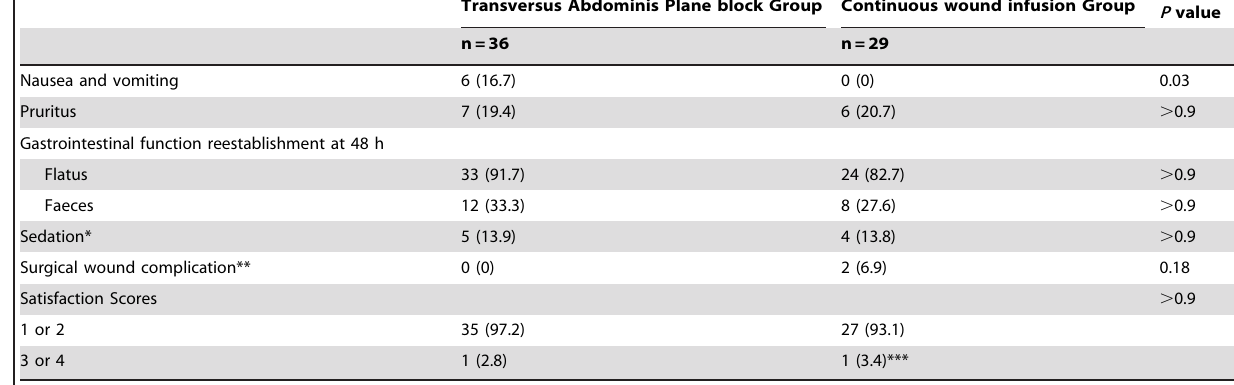
Table 2. Side effects and Satisfaction, presented as numbers (%).